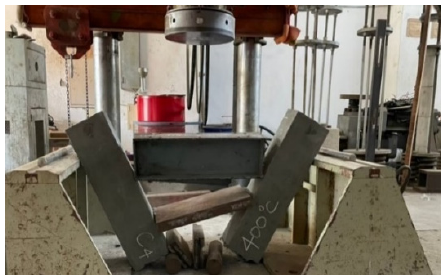
Figure 12. The fracture situation of the experimental group after being subjected to 400 °C.